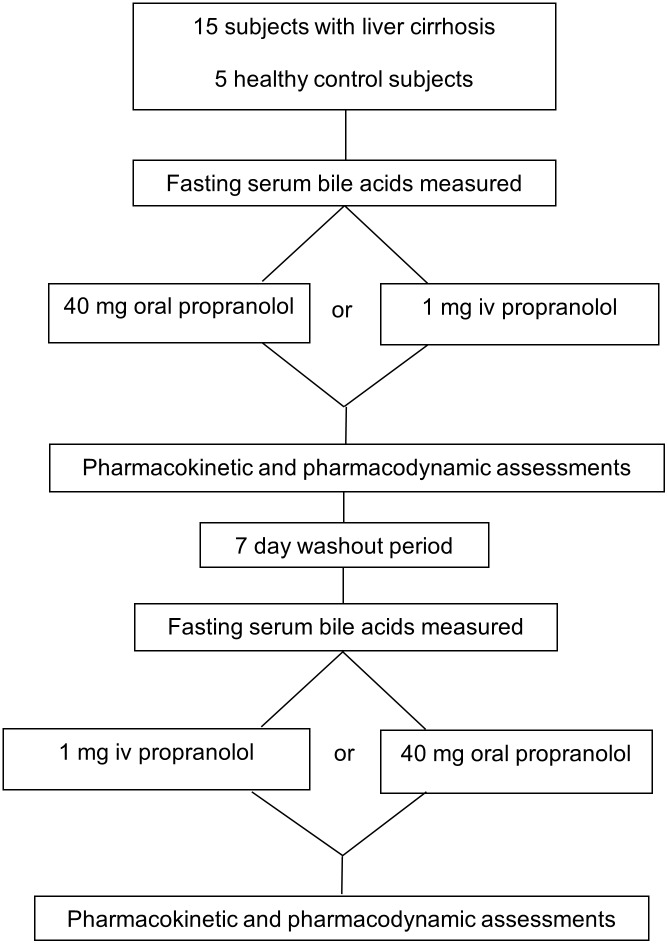
Study flow chart.